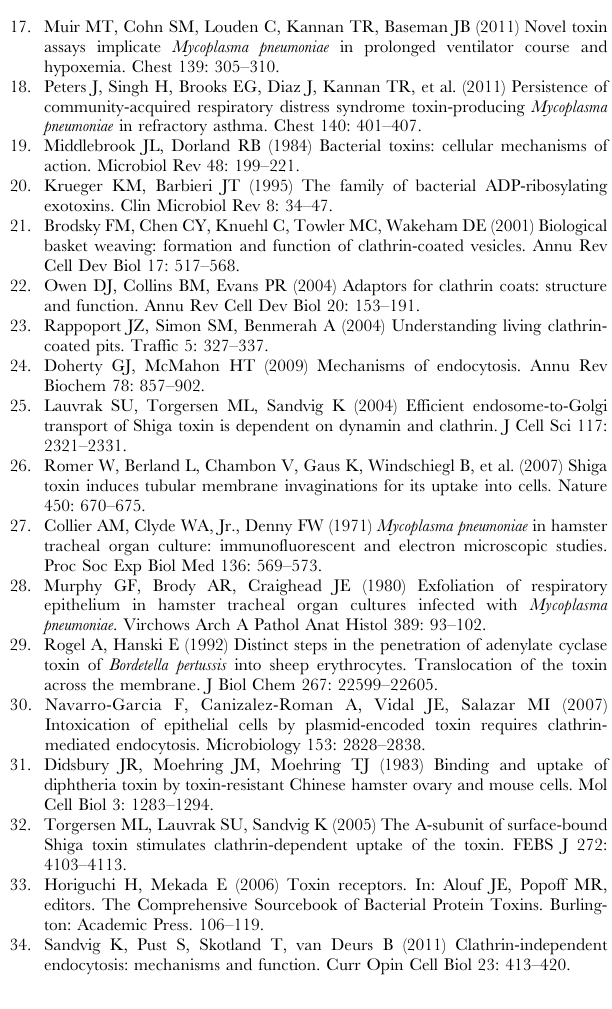
a wide range of cell lines. HEp2, A549, Vero and CHO for 1 h at 37 u C. Cells were fixed, permeabilized and analyzed for scanning microscopy as described under Fig. 1 legend. Figure S2 Effects of different inhibitory compounds on clathrin-mediated cell entry of rCARDS toxin. HeLa cells cultured on cover glass were pre-incubated 30 min at 37 u C with 5 mM of Methyl-2-cyclodextrin or 100 m M of Monodansylcada- verine or 1 m g Filipin. Subsequently, cells were treated with 10 m g/ml rCARDS toxin or 10 m g/ml Tf or 0.5 m g/ml of cholera toxin. Treated cells were processed for immunofluorescence as described in Materials and Methods. Images were obtained by